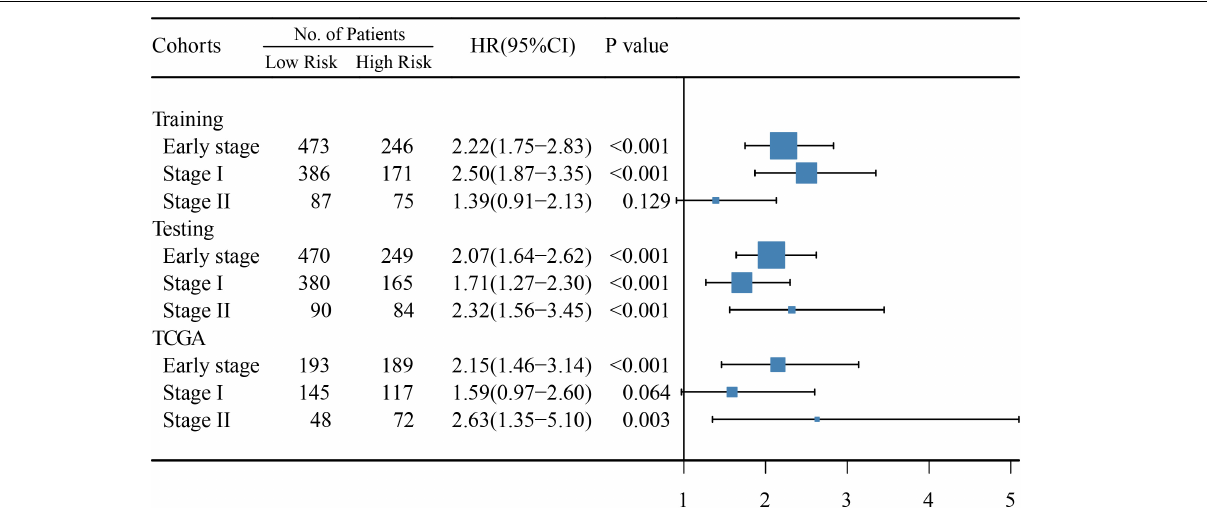
FIGURE 4 | Hazard ratio (HR) between high- and low-risk groups based on the autophagy-related gene pair index (ATGPI) was evaluated using univariate cox proportional hazards regression. The length of the horizontal line corresponds to the confidence interval, and the size of the blue square is proportional to the number of patients. The vertical line indicates that HR is equal to